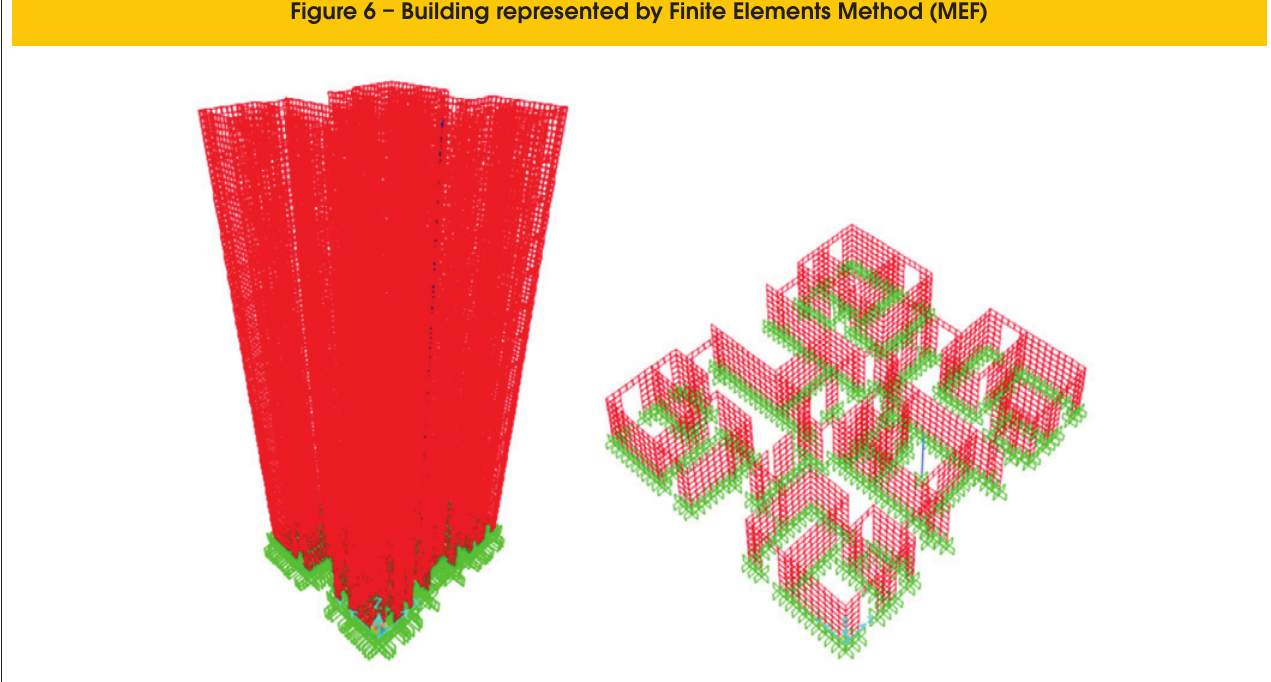
Figure 6 – Building represented by Finite Elements Method